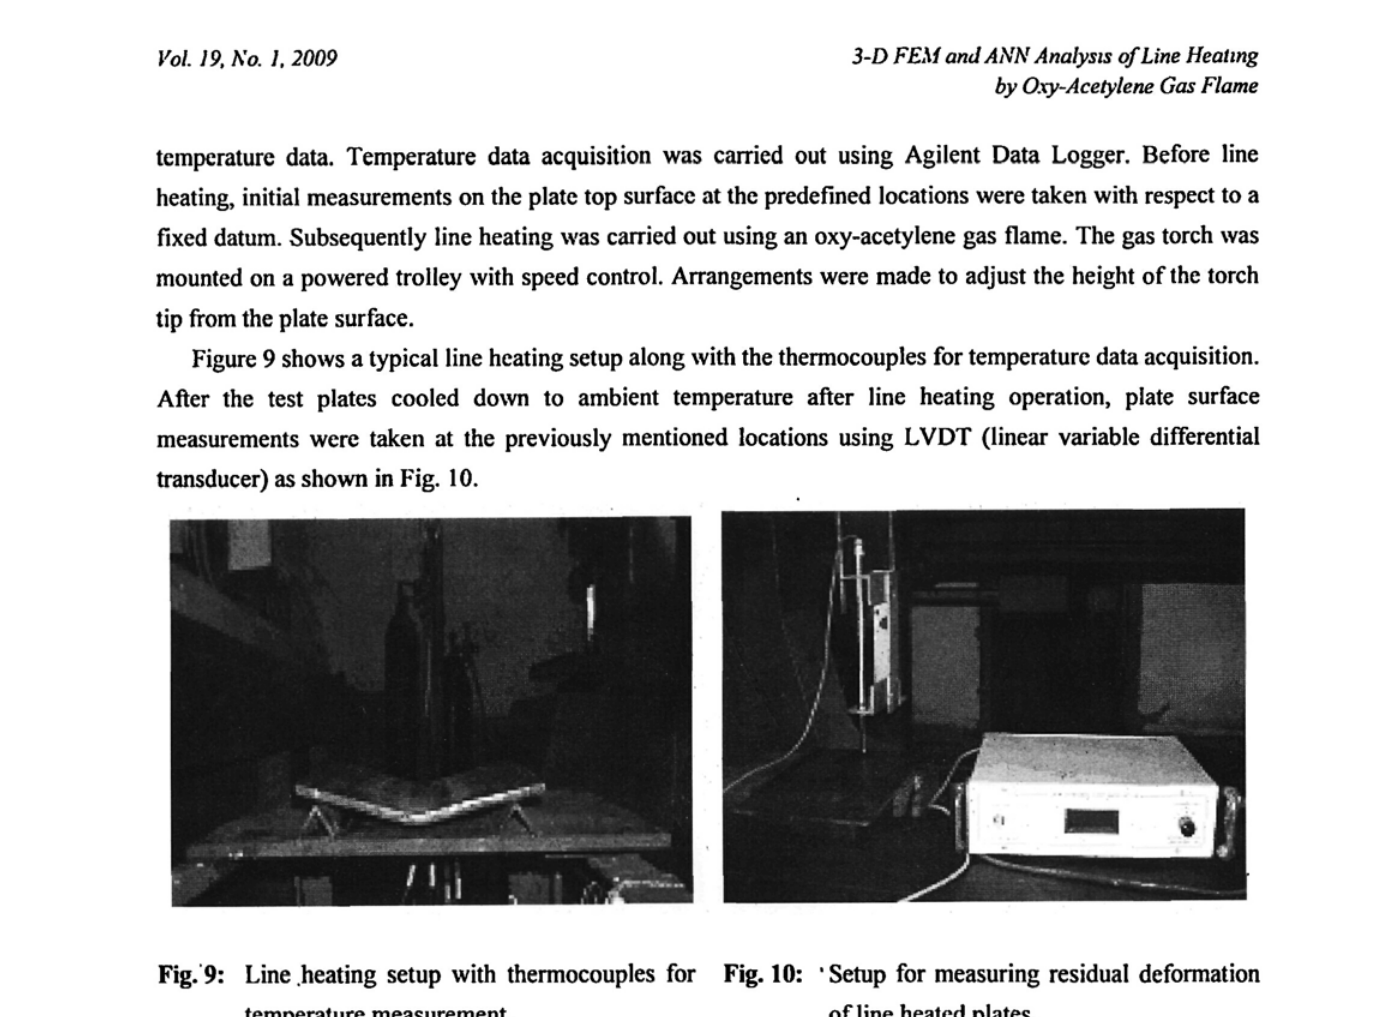
Fig. 9: Line .heating setup with thermocouples for Fig. 10: · Setup for measuring residual deformation temperature measurement. of line heated